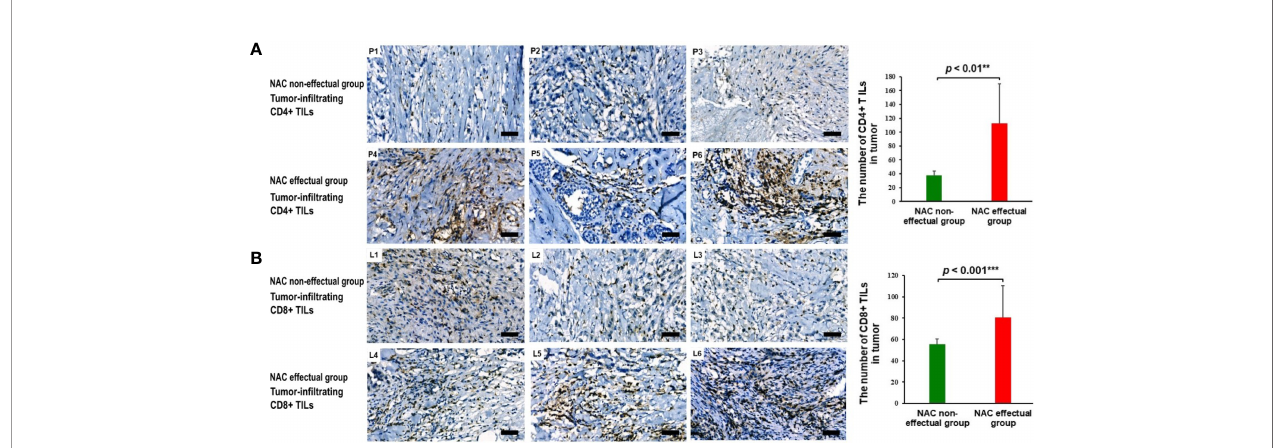
FIGURE 5 | (A) The presence and abundance of tumor-in fi ltrating CD4 + TILs as assessed with IHC staining between representing NAC non-effectual patients (P1, P2, P3) and NAC effectual patients (P4, P5, P6). Scale bars, 50 m m. (B) The presence and abundance of tumor-in fi ltrating CD8 + TILs as assessed with IHC staining between representing NAC non-effectual patients (L1, L2, L3) and NAC effectual patients (L4, L5, L6). Scale bars, 50 m m. IHC, immunohistochemistry. Data show means ± s.d. ** denotes p < 0.01 by Student ’ s t -test. *** denotes p < 0.001 by Student ’ s t